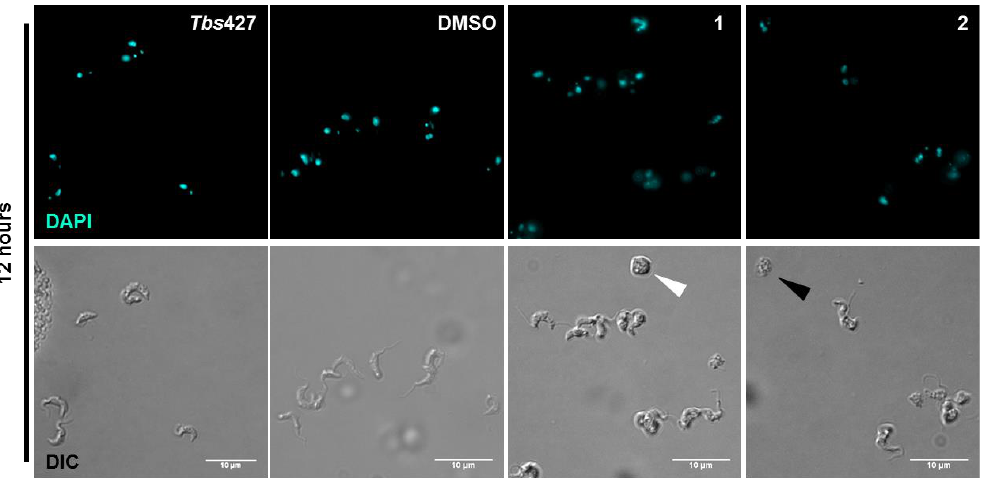
Figure 4. Morphological examination of DAPI-stained treated (with DMSO, 1 or 2 ) and untreated T. b. brucei 427WT cells; the marked cells (black and white arrow heads) were representative cells with characteristic effects on size, morphology, motility and configuration post-treatment with 1 or 2 .